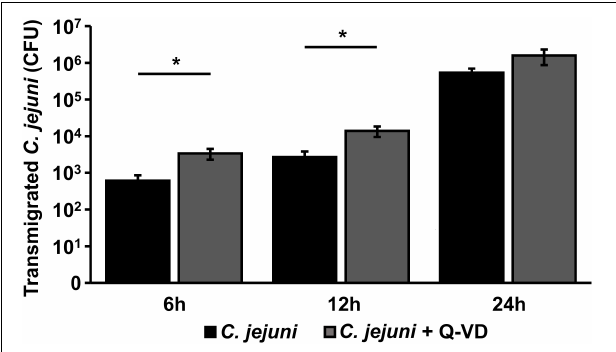
FIGURE 7 | Bacterial transmigration through an epithelial monolayer during C. jejuni infection. Co-cultures of HT-29/B6-GR/MR and THP-1 cells were infected with C. jejuni with or without apoptosis inhibitor Q-VD-OPh. Transmigration of C. jejuni through the epithelial monolayer was assessed 6, 12, and 24 h after infection of the co-culture. The numbers of colony forming units (CFU) are presented as mean values ± SEM on a logarithmic scale, n = 12, * p < 0.05, unpaired Student’s t